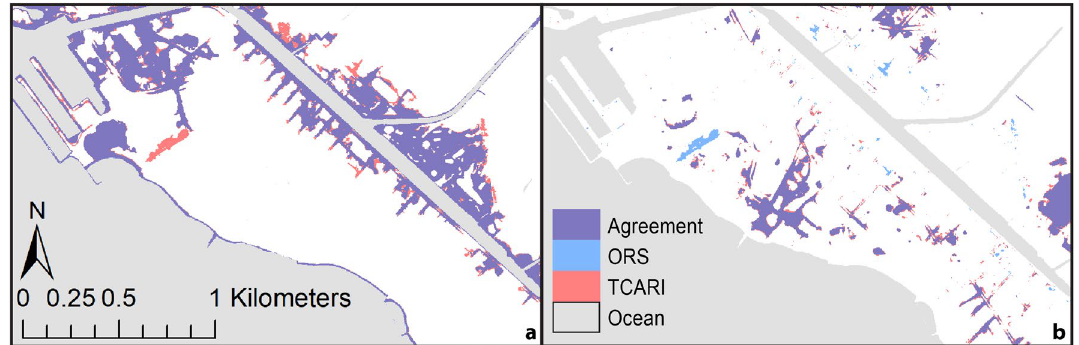
Figure 5. Maps depicting flooding in Waikīkī considering the NOAA Intermediate scenario by 2100 23 for the Honolulu tide gauge (1.19 m) distinguishing between ( a ) surficially connected and ( b ) topographically isolated; purple—area of agreement, blue—ORS method only, red—TCARI method only. (Maps generated with ArcGIS Desktop 10.8.2; http:// www. esri. com).